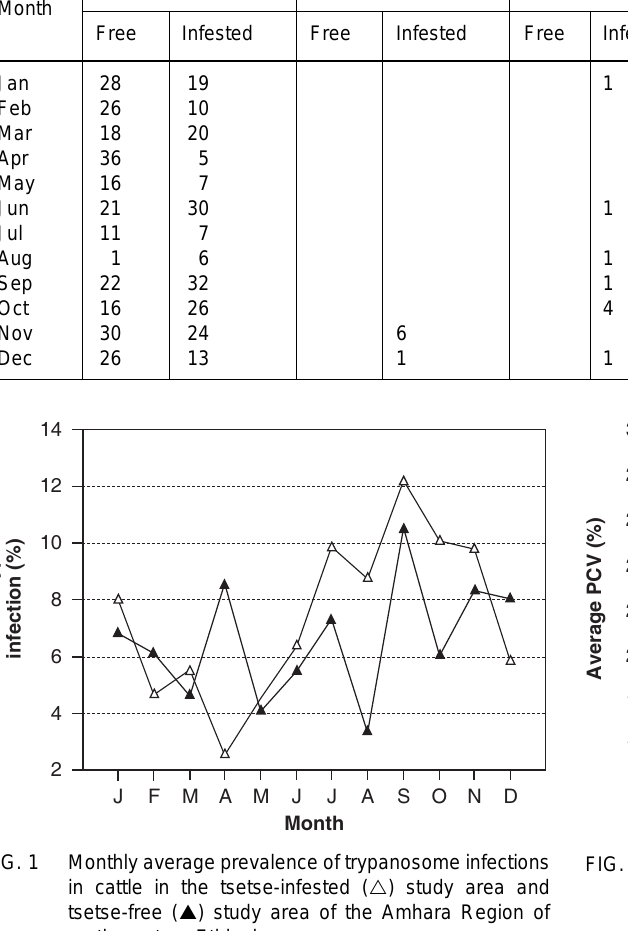
TABLE 1 Monthly total number of cattle with T. vivax, T. congolense, T. brucei or mixed infection in the tsetse-free study area and tsetse-infested study area of the Amhara Region of Ethiopia T.